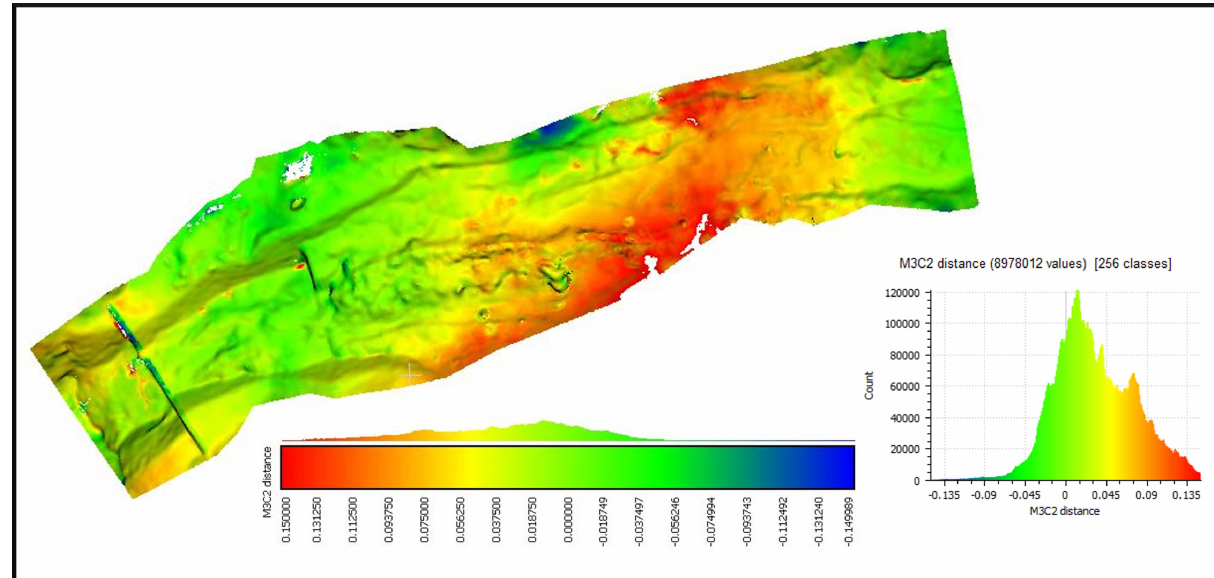
Figure 5. Distance map between 3DFZ and PS dense point clouds of May 2017 survey (best viewed in color).